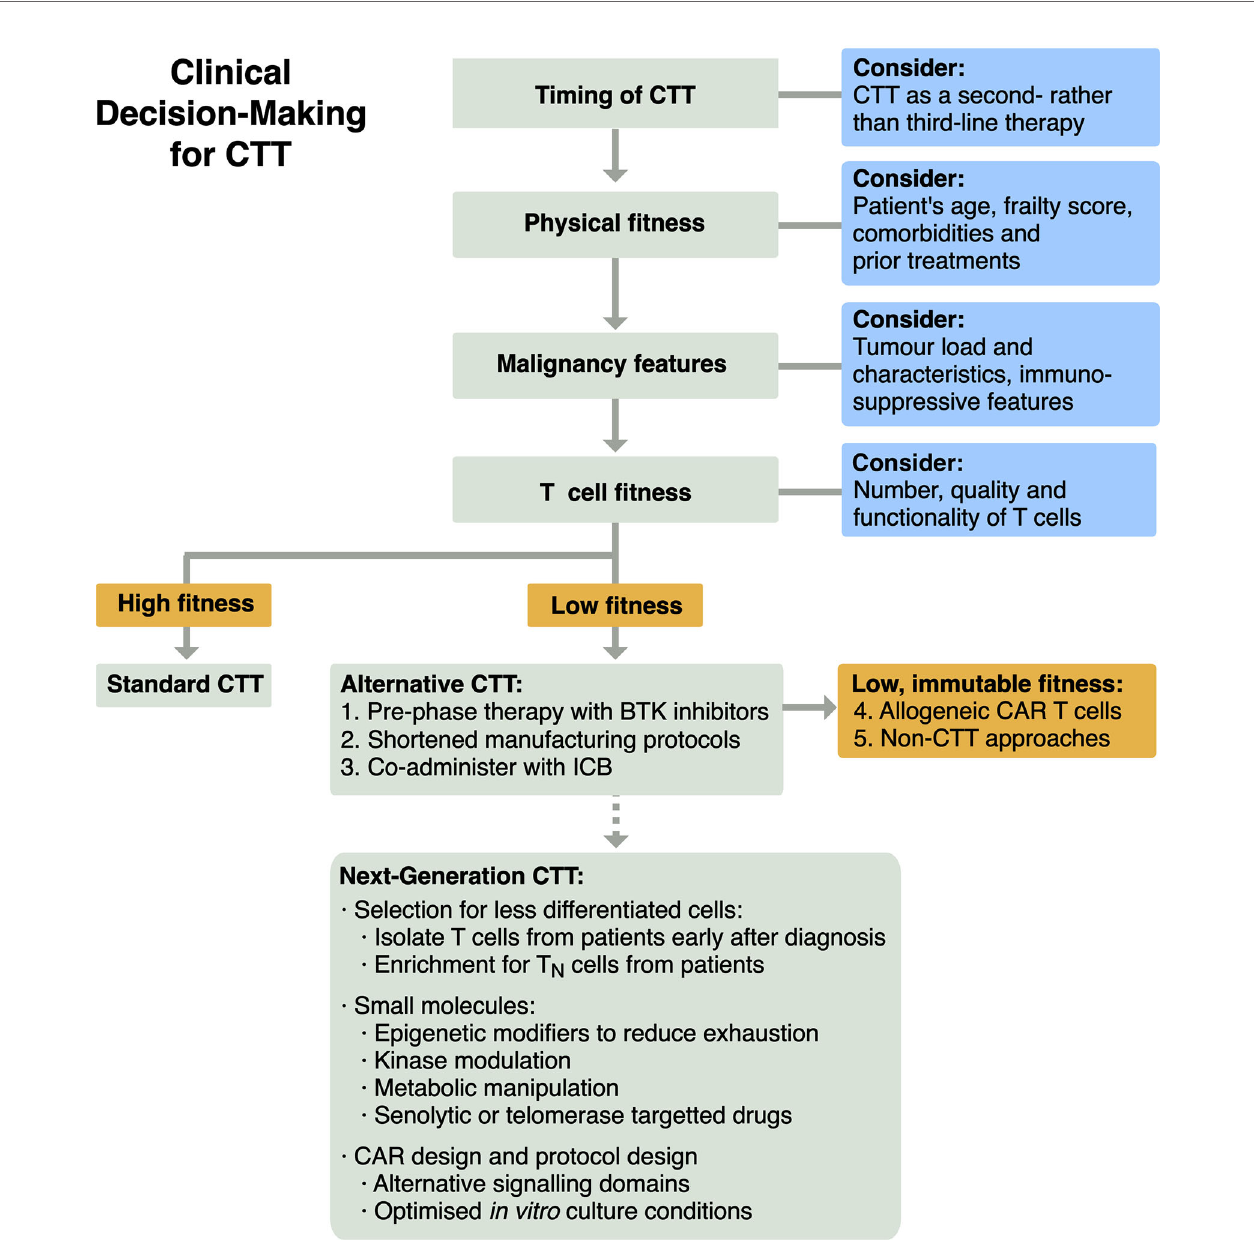
FIGURE 3 | Schema for clinical decision-making for CTT to integrate evaluation of T cell fi tness for